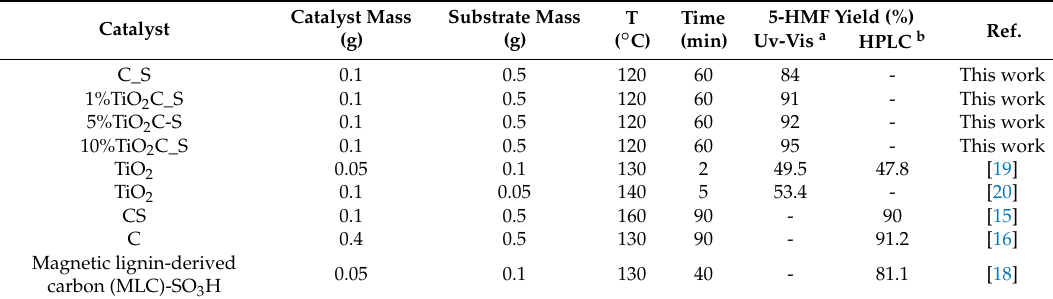
Table 3. Comparison of results of the dehydration of fructose (substrate) into 5-HMF in DMSO using carbonaceous and TiO 2 -based solid acid